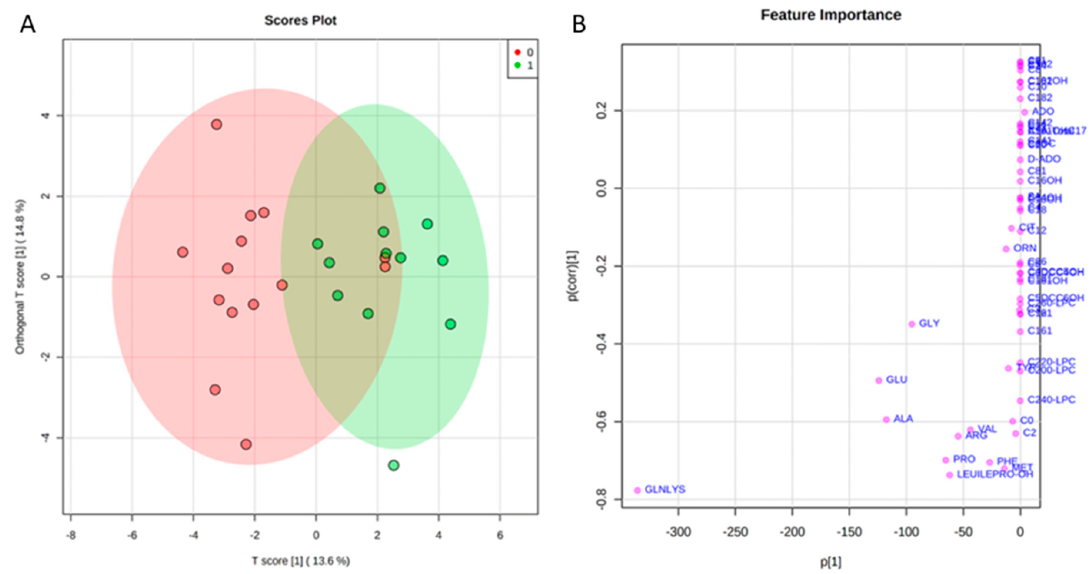
profiles. At the bottom center the most discriminating analytes in the construction of the orthogonal PLS-DA model are